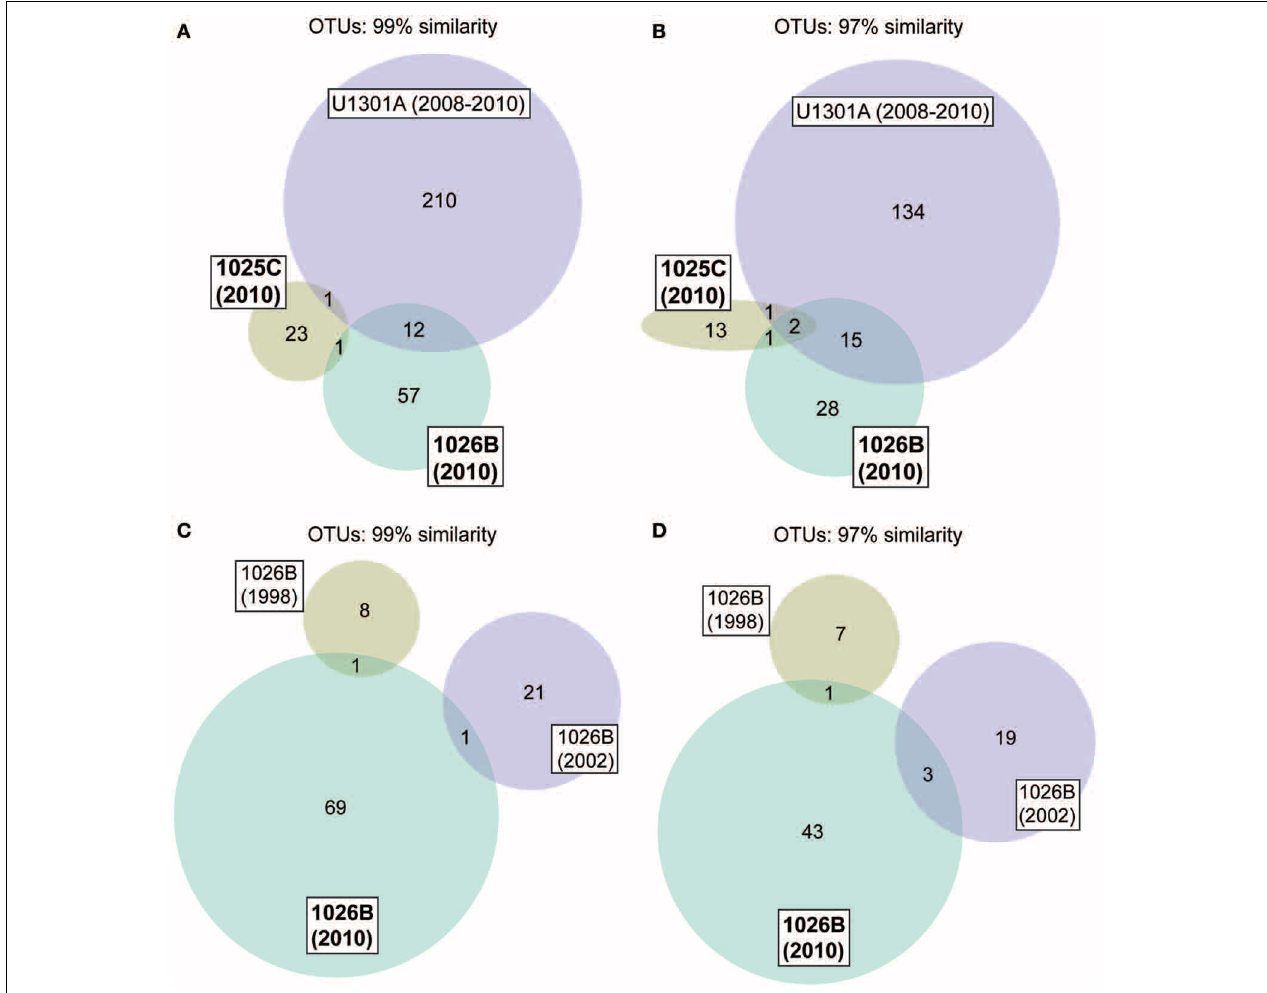
FIGURE 2 | Venn diagrams showing the overlap in microbial communities between Holes 1025C, 1026B, and U1301A fluids (A,B), and between Hole 1026B fluids collected in different years (C,D).